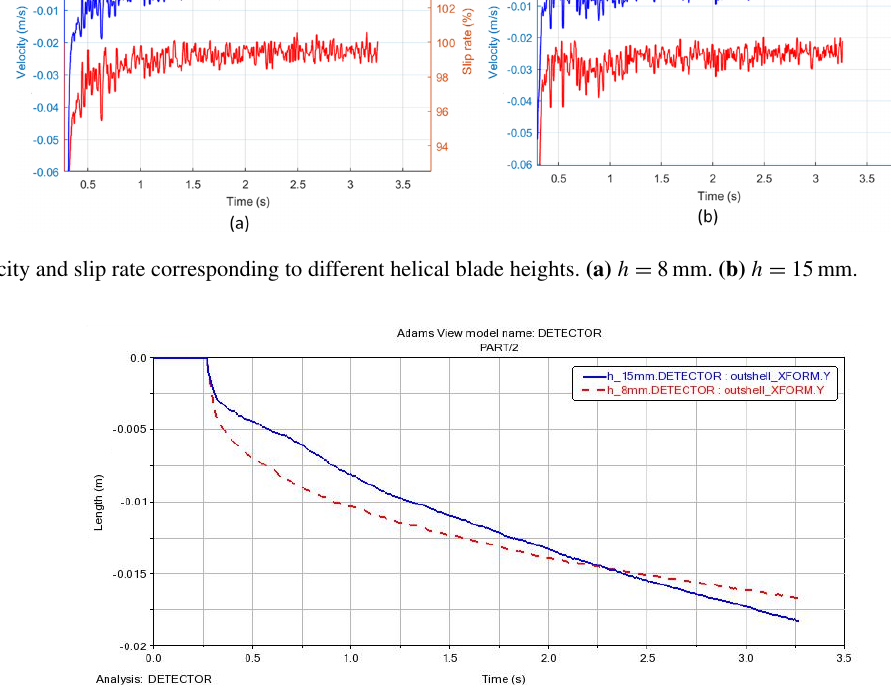
Figure 16. Displacement curves corresponding to different blade